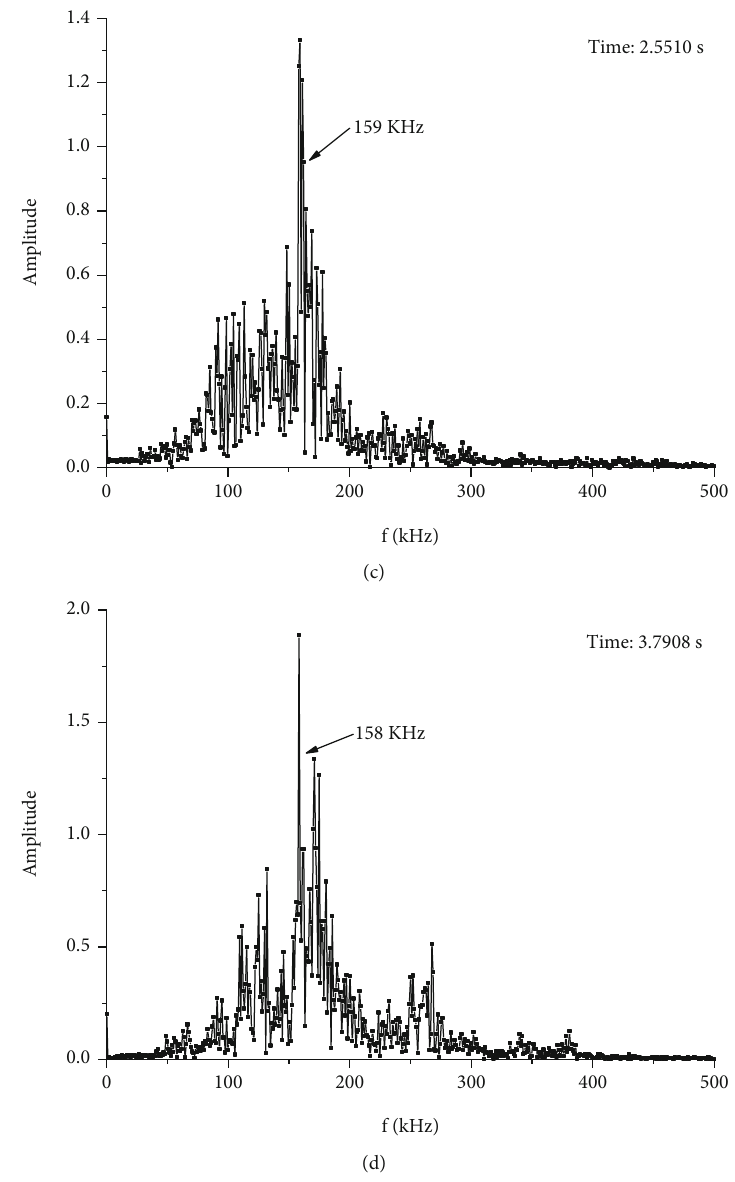
Figure 5: Waveform spectrogram of the waveform at the peak cutting force of H